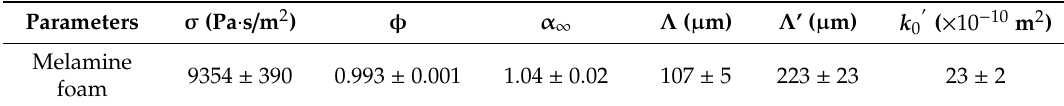
Table 1. Parameters of the melamine